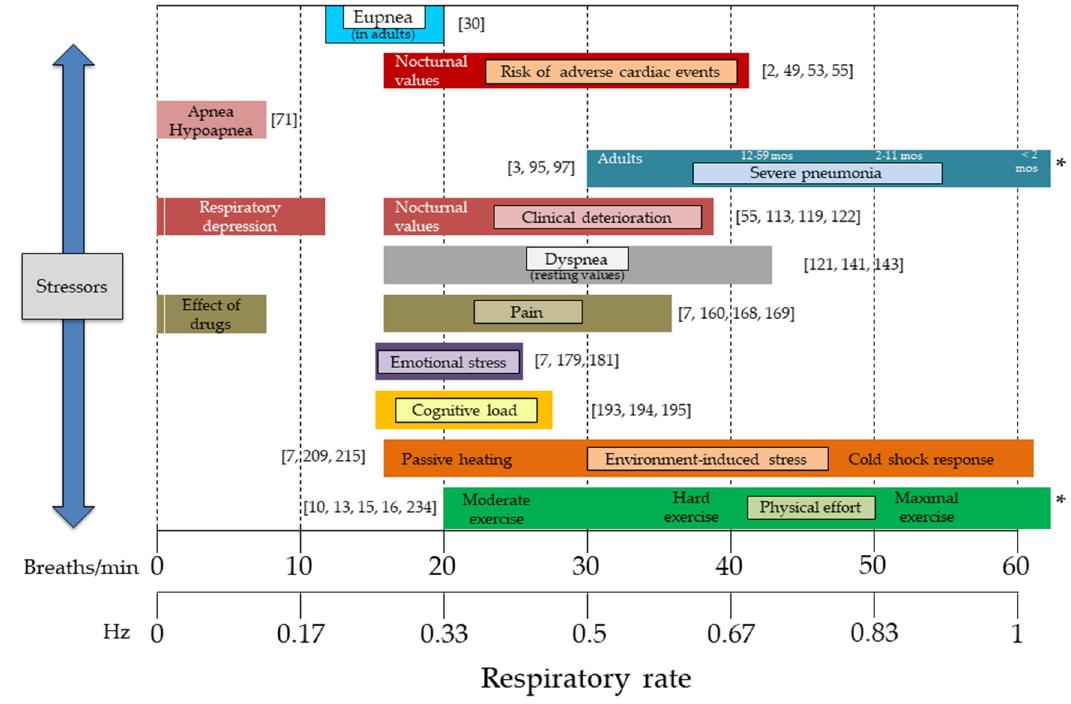
Figure 5. Schematic representation of how respiratory rate (values expressed both in breaths / min and in Hz) may change in response to di ff erent stressors. The range of respiratory rate values reported for each stressor has been defined according to the cited references (numbers in square brackets), but these values should only be considered as plausible examples. f R values refer to adults if not otherwise stated. * it is not unusual to observe f R values higher than 65 breaths / min. Mos, months. Computing solutions may also provide insight into the factors a ff ecting f R . For instance, analyses of ventilatory variability have been used to identify cognitive load and emotional stress [9,191], but further research is needed to guide their implementation in respiratory monitoring